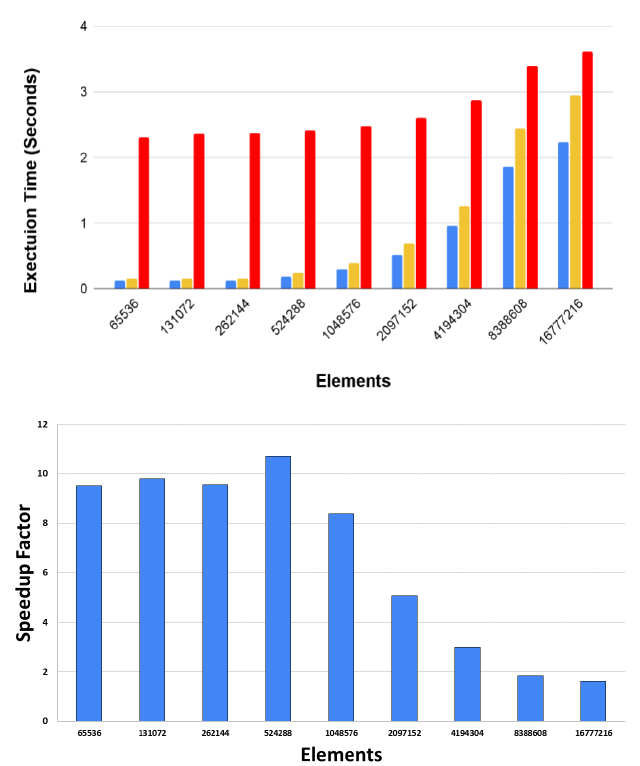
Figure 2. Top figure: execution time of the three different CG versions: NVIDIA reference code (Listing 1) in red color, optimized version using CUDA Graph (Listing 2) in blue color, and optimized version without using CUDA Graph (in yellow color). Bottom figure: speedup achieved by the optimized version using CUDA Graph (Listing 2) w.r.t. the NVIDIA version (Listing